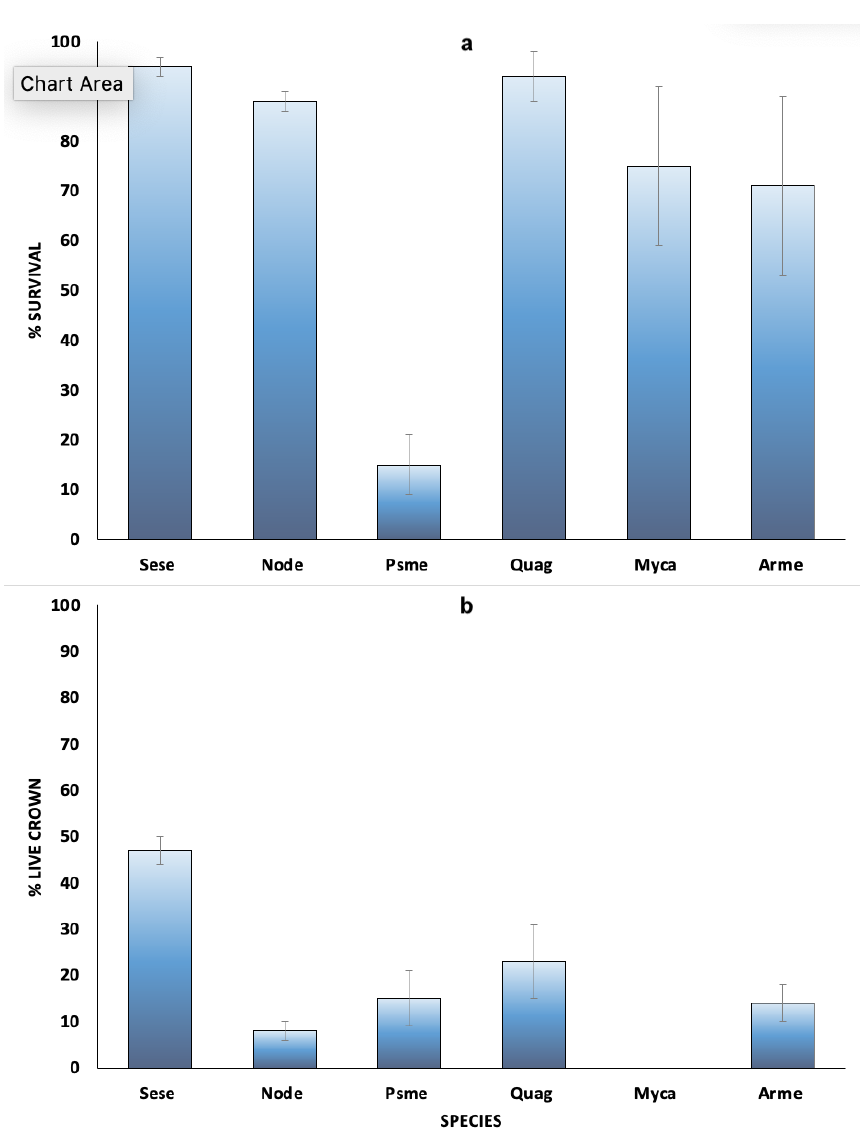
Figure 1. Percent survival ( a ); and percent trees exhibiting crown retention ( b ); following a high severity crown fire in Big Basin Redwoods State Park, California. Sese = Sequoia sempervirens (D. Don) Endl.; Node = Notholithocarpus densiflorus (Hook. & Arn.) Manos; Psme = Pseuotsuga menziesii (Mirb.) Franco; Quag = Quercus agrifolia Nee.; Myca = Myrica californica (Cham. & Schltdl.) Wilbur; Arme = Arbutus menziesi Pursh. Error bars indicate standard error.